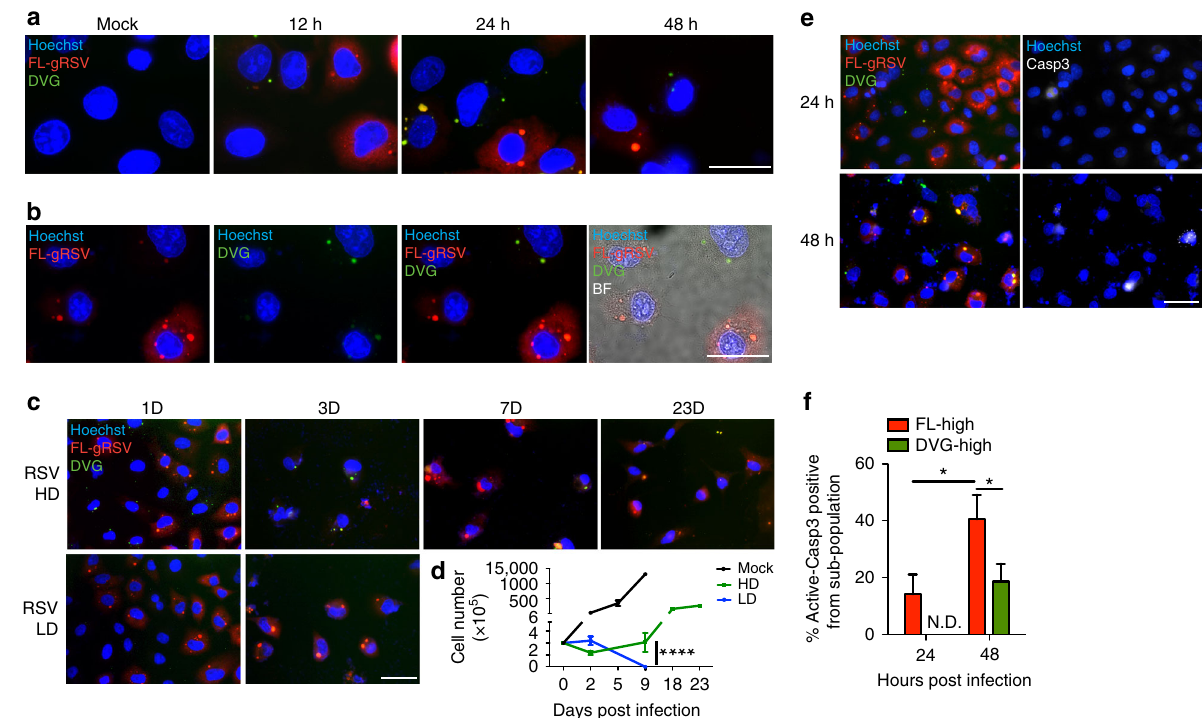
Fig. 3 Heterogeneous accumulation of DVGs and FL-genomes during RSV infection. a Representative RNA FISH merged images of A549 cells infected with RSV HD for 12, 24, and 48 h. b Representative single channel and merged images of A549 cells infected with RSV HD for 24 h. Hoechst signal was merged with gRSV, DVG, or bright fi eld (BF) respectively. c Representative RNA FISH merged images of A549 cells infected with RSV HD and RSV LD on days 1, 3, 7, and 23 post infection. d Total cell numbers of RSV HD and LD infected cells during the infection time course ( n = 3). e Representative merged images of RNA FISH-IF for active caspase-3 protein (white) staining of A549 cells infected with RSV HD for 24 or 48 h. Hoechst signals were merged with either RNA FISH probes signals (left column) or active caspase-3 signal (Casp3, right column). f Percentage of active caspase-3 positive cells within FL-high and DVG-high cells infected as in e ( n = 3). Data are shown as mean ± s.e.m. * P < 0.05, *** P < 0.001, and **** P < 0.0001 by two-way ANOVA with Bonferroni ’ s post hoc test. ns, non-signi fi cant. ND, non-detectable. Images were taken at a × 40 ( c , e ) or × 100 ( a , b ) magni fi cation. Scale bar = 20 μ m. See also Supplementary Fig.